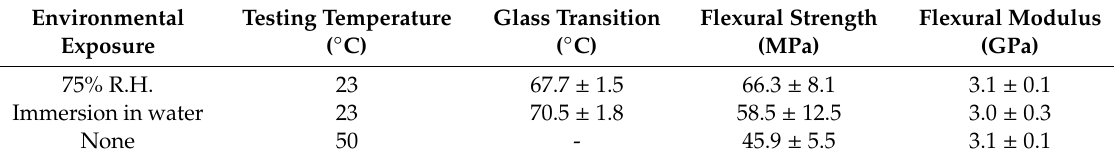
Table 3. Glass transition temperature ( T g ) and mechanical properties (measured in flexural mode) on cold-cured Hybrid DGEBA system after different environmental exposures.